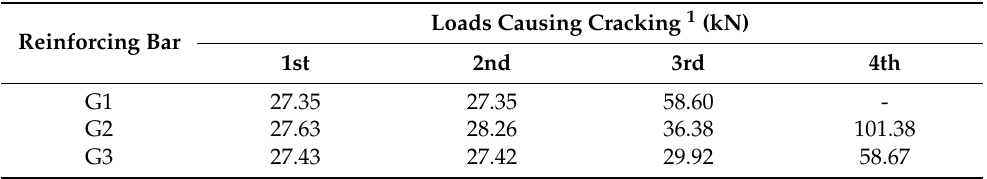
Figure 5. Load-mean strain curves obtained with different GFRP reinforcing bars (having different surface configurations) embedded in concrete C1. Table 2. Loads causing cracking in the crack formation stage (concrete C1).